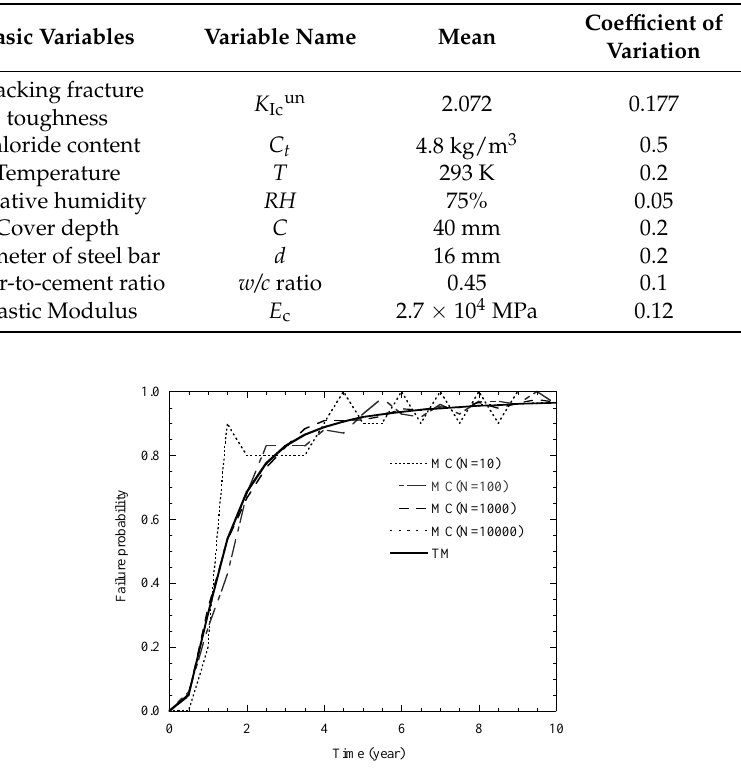
Figure 8. Comparison of TM and MC on cover cracking probability.